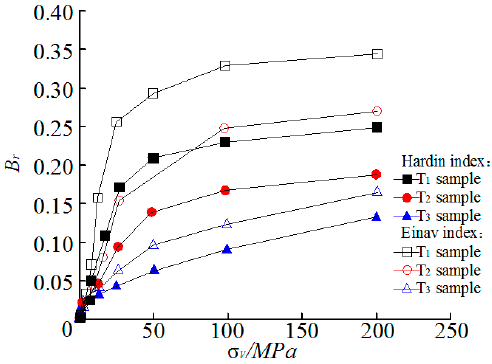
Figure 9. Influence of stress level on relative breakage.